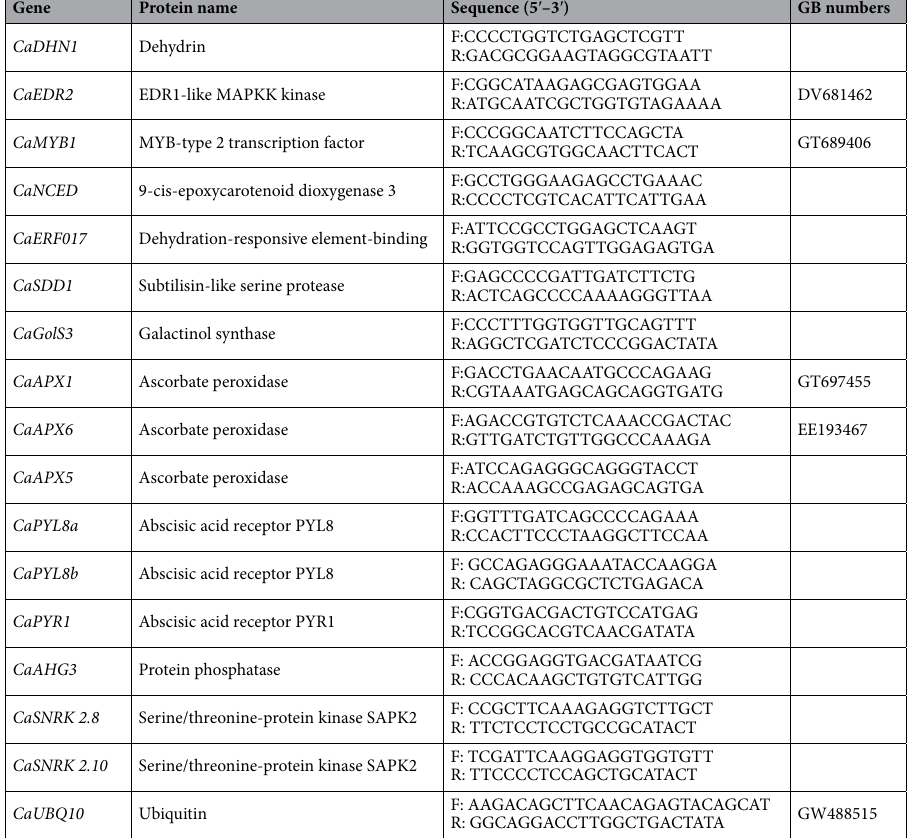
Table 2. Candidate genes for drought tolerance, protein name, corresponding primers and GenBank (GB) accession numbers of coffee EST sequences used in the qPCR